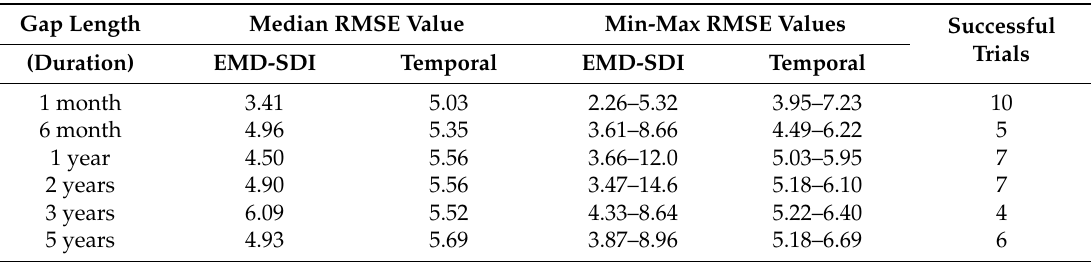
Table 1. Summary statistics for the EMD-SDI and temporal data imputation methods, using gap